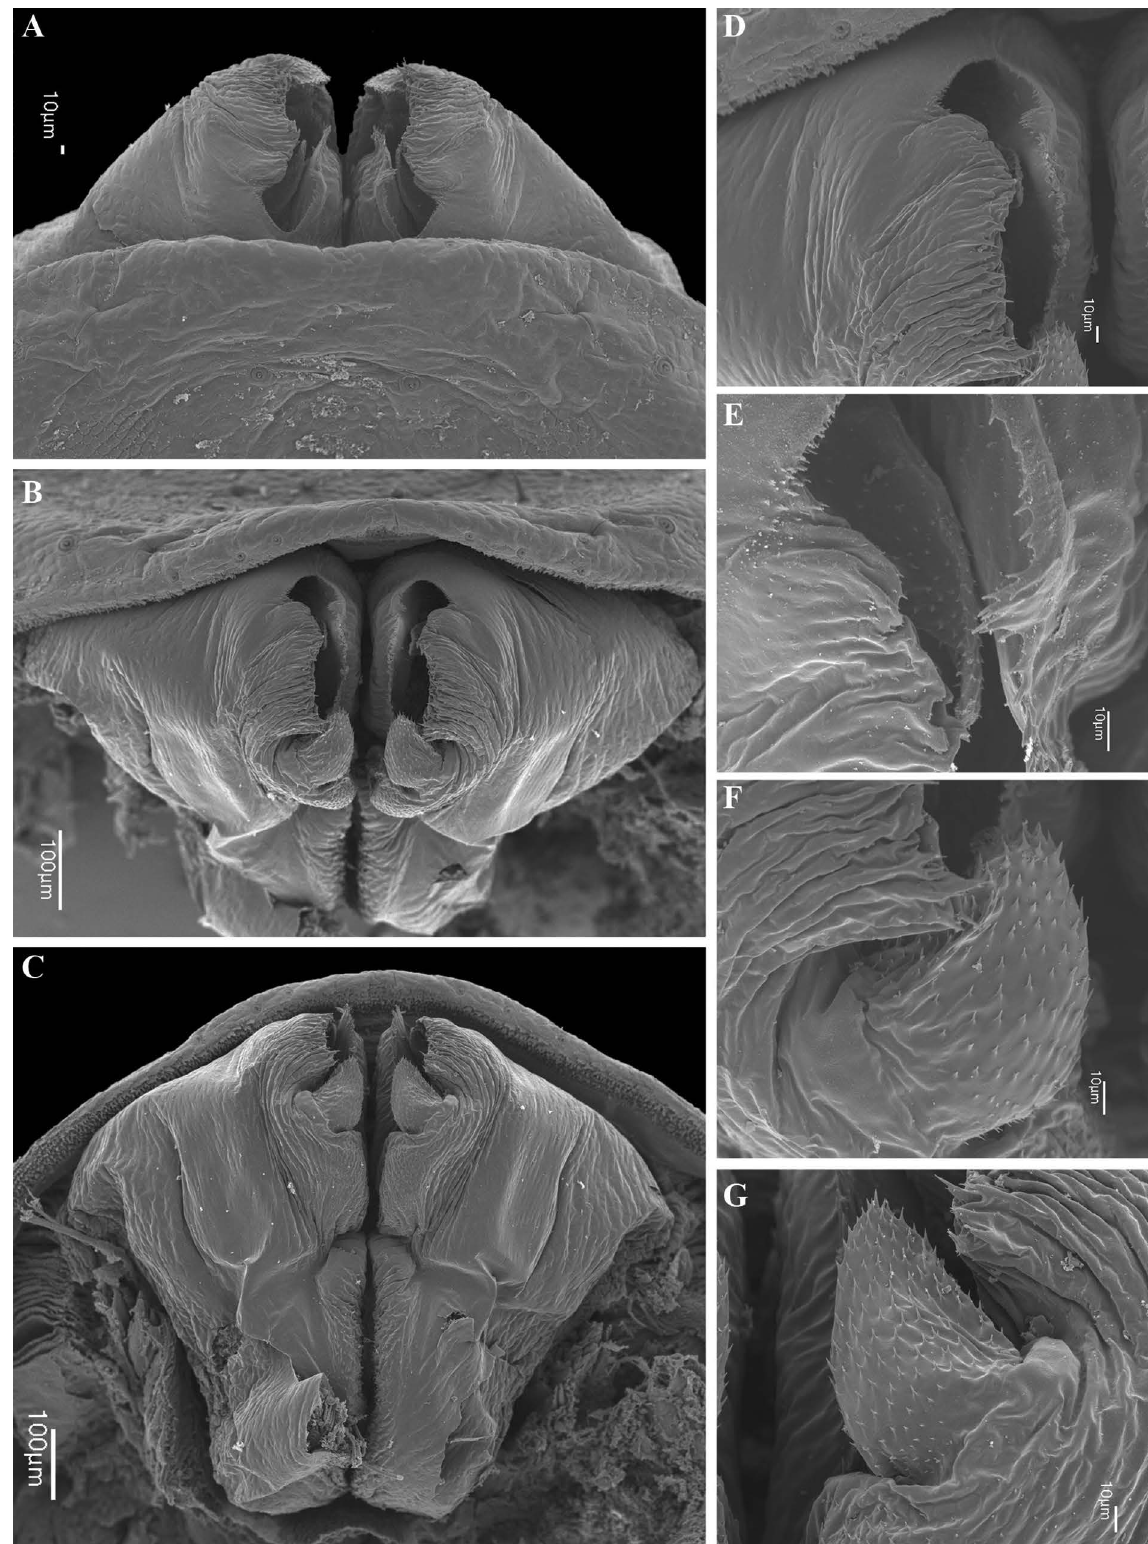
Fig. 128. Sarax tiomanensis sp. nov. (AMCC [LP 11998]), male gonopod. A . Ventral view. B . Posterior view. C . Dorsal view. D . Sinistral side of gonopod. E . Lateral lobe 2, processus internus and lamina medialis. F . Lateral lobe 2 and dorsal lobe. G . Dorsal